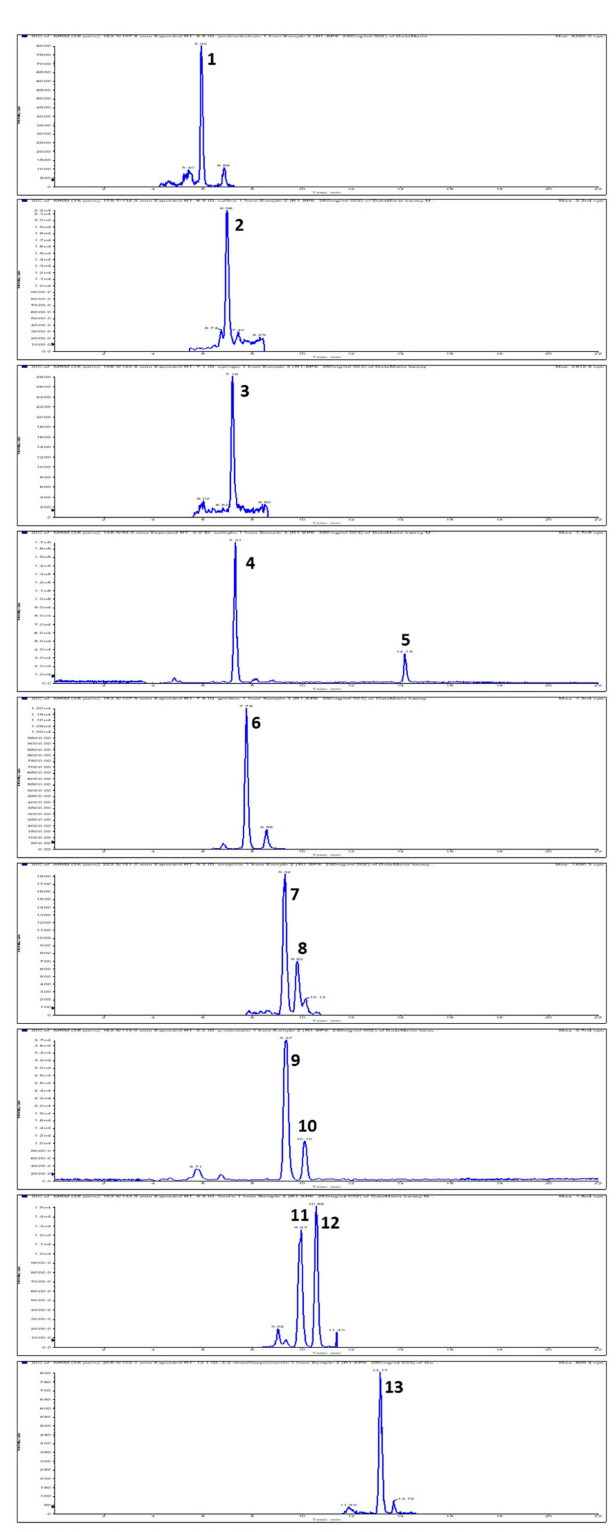
Figure 1. Extracted LC-MS-MRM chromatogram of phenolic acids found in prickly pear. MRM transition are given in brackets: 1, protocatechuic (m / z 152.9 → 107.8); 2, ca ff eic (m / z 178.7 → 134.9); 3, syringic acid (m / z 196.9 → 122.8); 4, 4-hydroxy-benzoic (m / z 136.9 → 93); 5, salicylic (m / z 136.9 → 93); 6, gentisic (m / z 152.8 → 107.9); 7, trans -sinapic acid (m / z 222.8 → 148.9); 8, cis -sinapic acid (m / z 222.8 → 148.9); 9, p -coumaric (m / z 162.8 → 119); 10, m -coumaric (m / z 162.8 → 119); 11, ferulic (m / z 192.8 → 133.9); 12, isoferulic acid (m / z m / z 192.8 → 133.9); 13, 3,4-dimethoxycinnamic acid (m / z 206.8 →